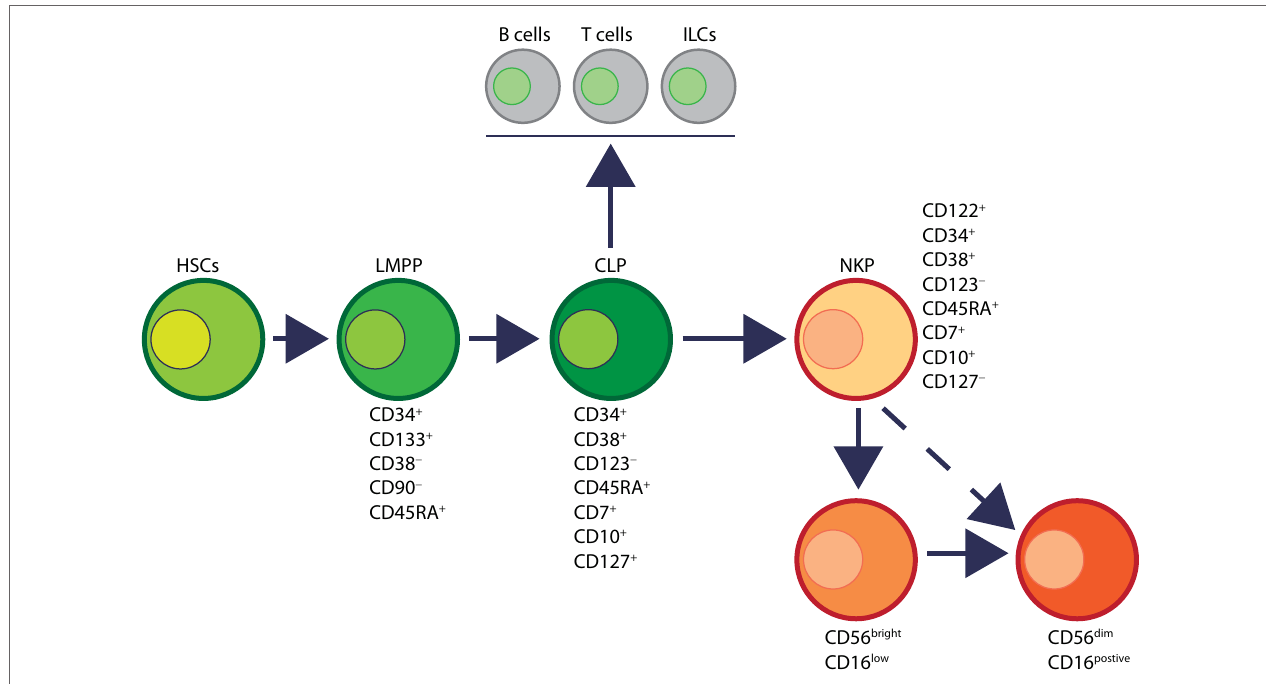
FiGURe 4 | Developmental origin of human natural killer (NK) cells. In human, the primary organ where NK cells mature is still under active investigation. There is ample evidence that NK cells can mature from the lymph nodes (LNs). Lin − CD34 + hematopoietic stem cells (HSCs) differentiate into CD45RA + lymphoid-primed multipotential progenitor (LMPP). By expressing CD38, CD7, CD10, and the cytokine receptor CD127 (IL-7 receptor-alpha), LMPPs transition into common lymphoid progenitors (CLPs) that have the potential to make lineage commitment into Pro-B, Pre-T, NK cell progenitors (NKPs), or other innate innate lymphoid cells. Expression of CD122 (IL-2R β ) marks the irreversible fate decision of CLPs into NK lineage. The appearance of CD56 (neural cell adhesion molecule) indicates a final transition of immature NK cell (iNK) into mature NK cells. Most of the iNK cells transition into a minor CD56 bright population (~5%) that convert into major CD56 dim ( > 90%) population. It is also suggested that iNK cells can directly give rise to CD56 dim population (dotted arrow) that is yet to be